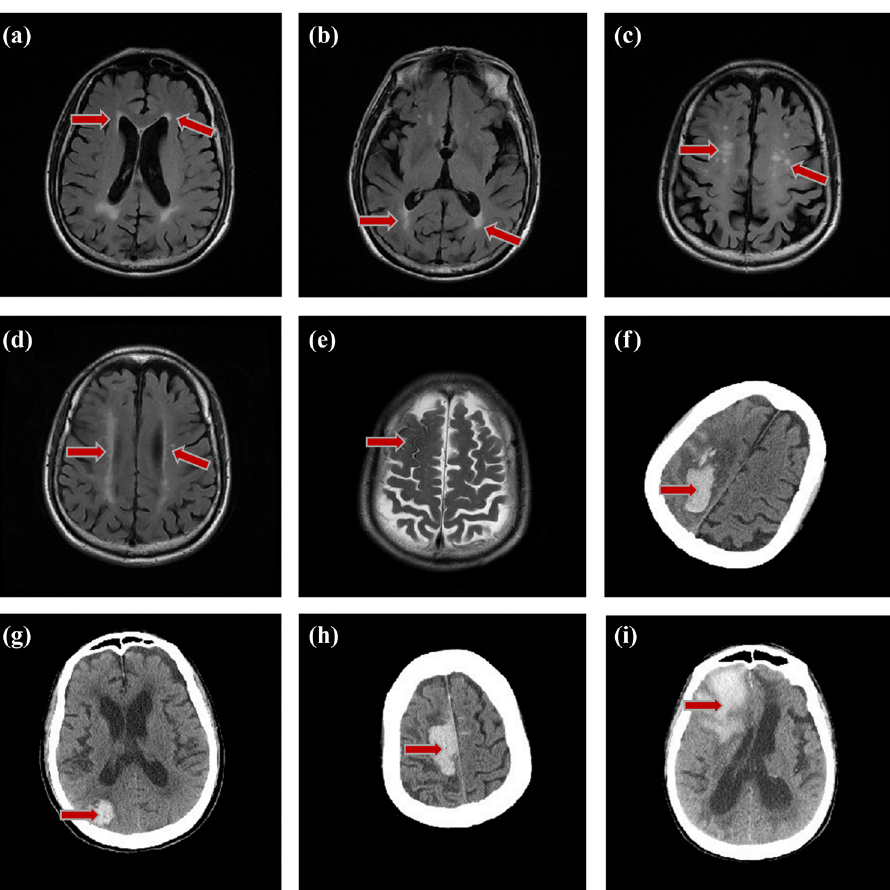
Figure 2: Distribution of early LA and hemorrhages in case 12. An 86 - year - old male patient, occipital prominent LA and subcortical patchy distribution of white matter appeared 3 years before the ICH. ( a ) Score 1 in the frontal lobe white matter ( periventricular 1, deep 0, juxtacortical 0 ) . ( b ) Score 4 in the occipital lobe white matter ( periventricular 3, deep 1, juxtacortical 0 ) . ( a and b ) FO value = − 3 occipital prominent LA. ( c ) Subcortical multiple punctate LA, without clear periventricular white matter damage. ( d ) The bilateral white matter lesions were asymmetric, with the right white matter lesions severer. ( e ) T2 shows old convex subarachnoid hemorrhage in August 2009. ( f ) Shows that ICH occurred in right parietal - occipital lobe in 2012. ( g – i ) CT shows recurrent ICH occurred in right occipital lobe, parietal lobe, and frontal lobe in 2014, 2016, and 2018, all on the same side of convex subarachnoid